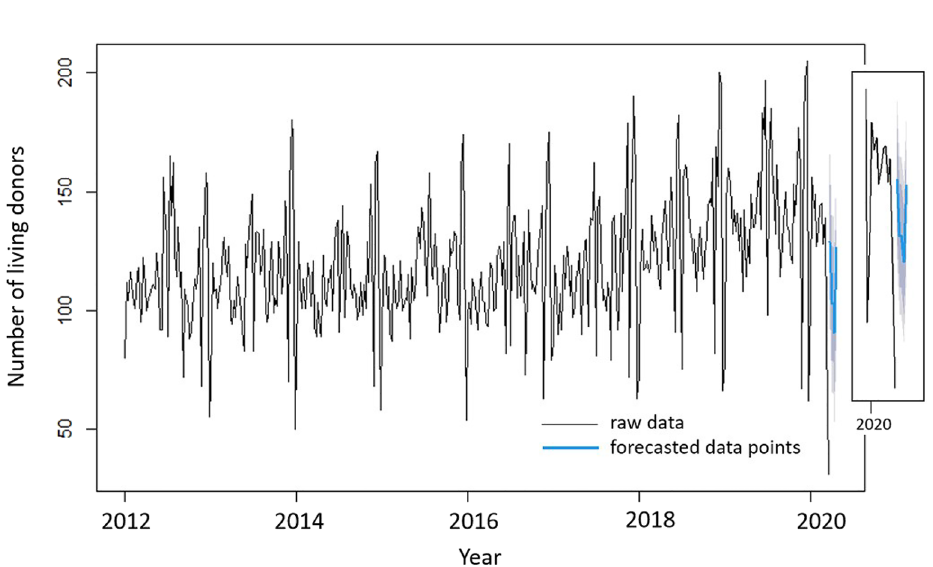
Figure 13. Raw data for the living organ donors along with blue line depicting the predictions by M1 ARIMA(6,1,0)(2,1,0) with drift. Also shown are the 80% confidence interval (dark grey) and the 95% confidence interval (light grey). The top right figure inset highlights the forecasted points and the confidence